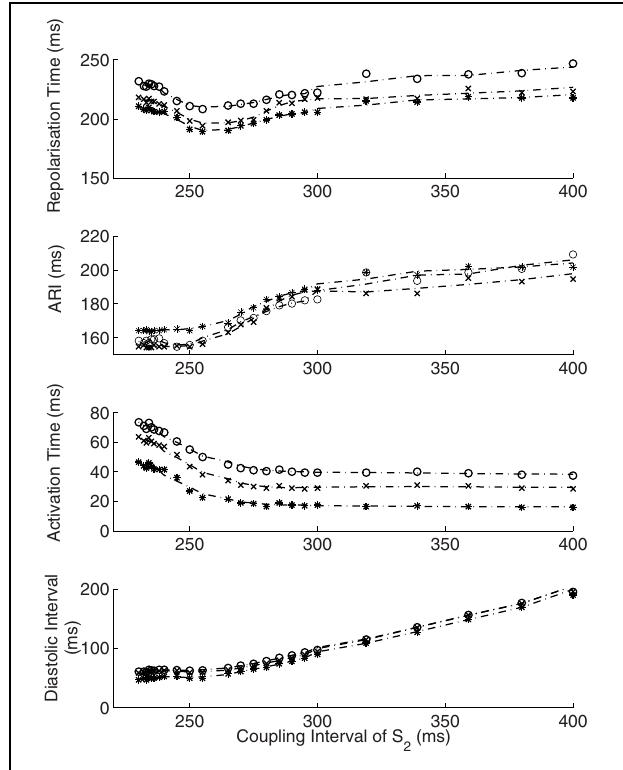
FIGURE 4 | Interactions of activation and ARI leading to repolarization time change. The response of diastolic interval (DI), activation time and ARI to shortening coupling interval are shown, with the overall repolarization time dynamic shown in the top panel. As paced intervals decrease, diastolic intervals decrease initially in a linear fashion ( Bottom panel). The reduction in DI is associated with a non-linear reduction in ARI (restitution). As coupling intervals become very short, activation time increases due to the effect of conduction velocity restitution acting between the stimulus site and the recording electrode. Activation time increases prevent further reduction of local diastolic interval ( Bottom panel), which is seen to level off. ARI restitution is blunted at these short coupling intervals. Repolarization time thus increases as a result of increasing activation times. Representative patient data from RV (Star—early activating site, cross- mid activating site, circle- late activating site, dotted lines represent smoothed